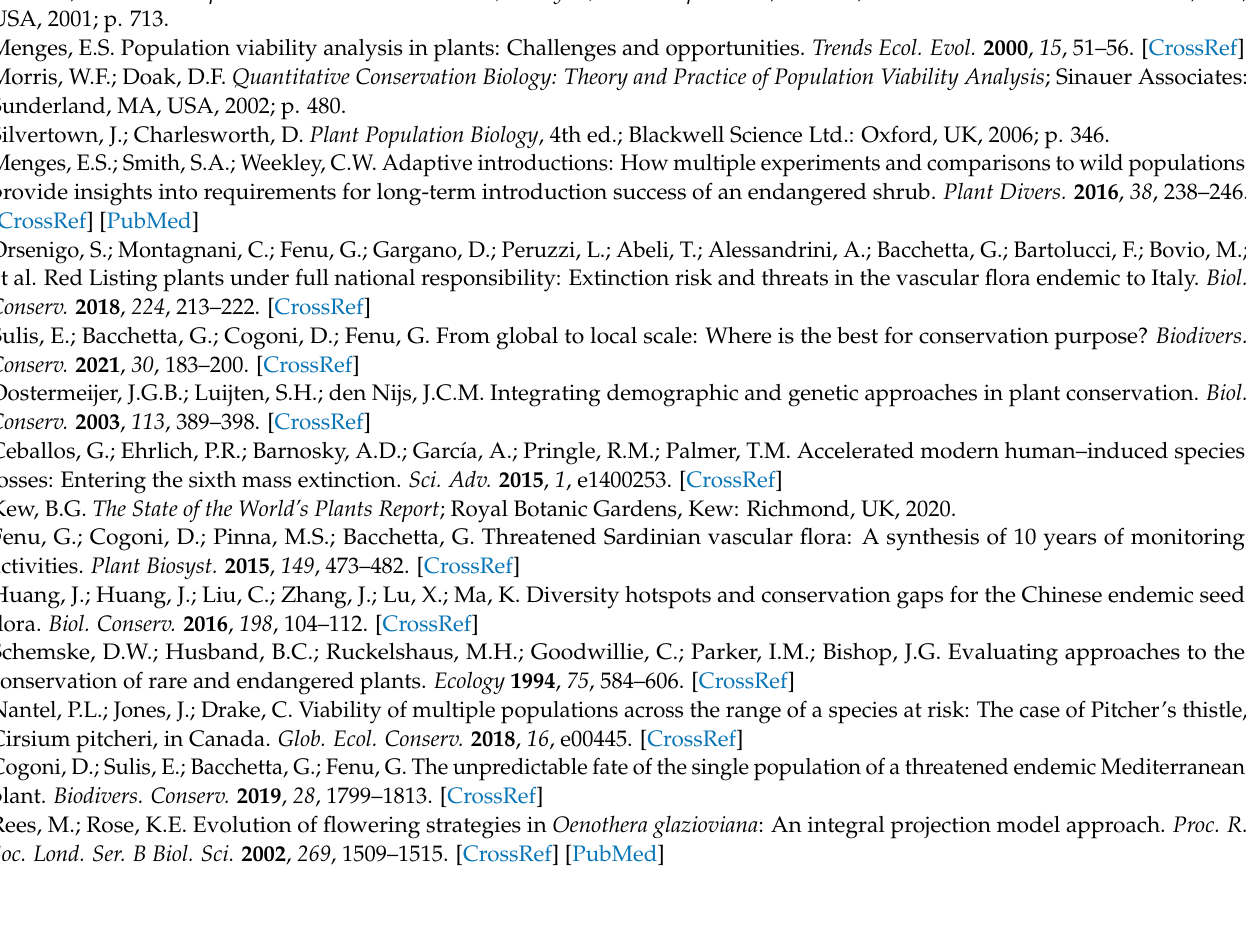
estimates. Table S2: Model selection table for the multimodel analyses studying the effect of the site characteristics on the abundance of mature individuals of C. alpis-lunae . Only models with a ∆ AICc < 4 were used to calculate the averaged coefficient estimates. Table S3: Model selection table for the multimodel analyses studying the effect of the site characteristics on the density of juvenile individuals of C. alpis-lunae . Only models with a ∆ AICc < 4 were used to calculate the averaged coefficient estimates. Table S4: Model selection table for the multimodel analyses studying the effect of the site characteristics on the density of juvenile individuals of C. alpis-lunae . Only models with a ∆ AICc < 4 were used to calculate the averaged coefficient estimates. Table S5: Model selection table for the multimodel analyses studying the effect of the cover of the different vegetation layers (i.e., ground, shrub, and canopy cover) on the cover of C. alpis-lunae . Only models with a ∆ AICc < 4 were used to calculate the averaged coefficient